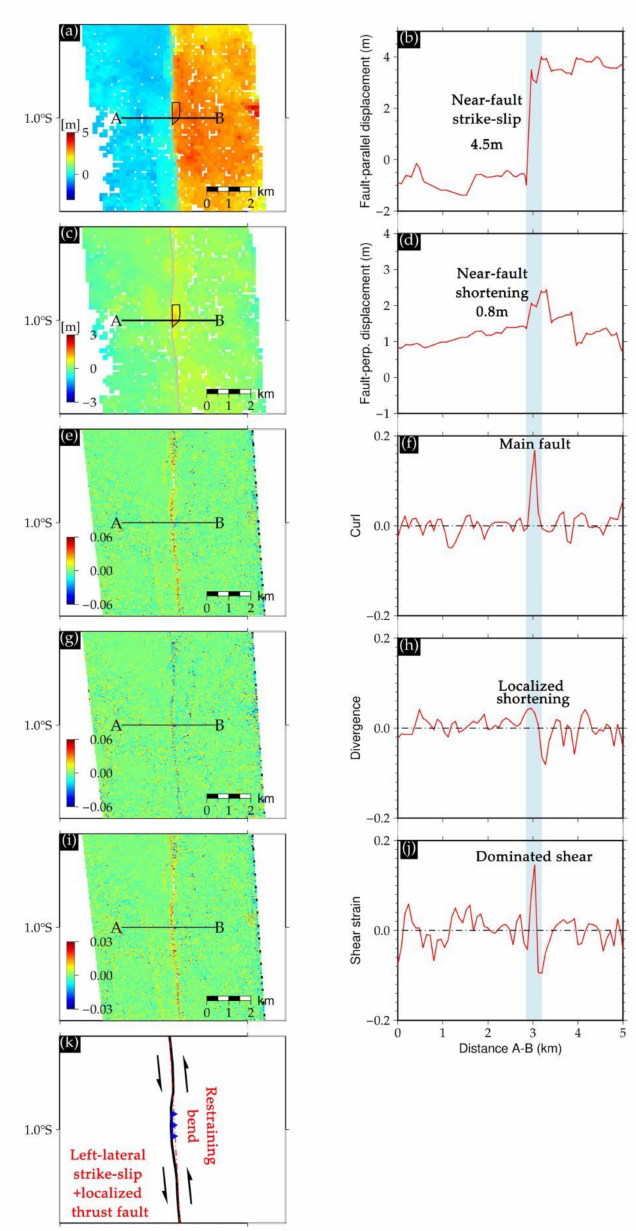
Figure 5. Deformation pattern showing a restraining bend in an area of localized shortening. ( a ) Fault-parallel displacement field; ( b ) across-fault fault-parallel displacement along profile AB; ( c ) fault-perpendicular displacement field; ( d ) across-fault fault-perpendicular displacement along profile AB; ( e ) curl field; ( f ) curl along profile AB, where the main rupture (main fault) can be identified from the peak of the curl profile; ( g ) divergence field; ( h ) divergence along profile AB, where divergence at the main rupture is positive, indicating localized shortening; ( i ) shear strain field; and ( j ) shear strain profile along profile AB, where shear strain values at the main rupture are positive, corresponding to predominant left-lateral shear strain; ( k ) geometric variation along the main rupture. The blue stripe denotes the main